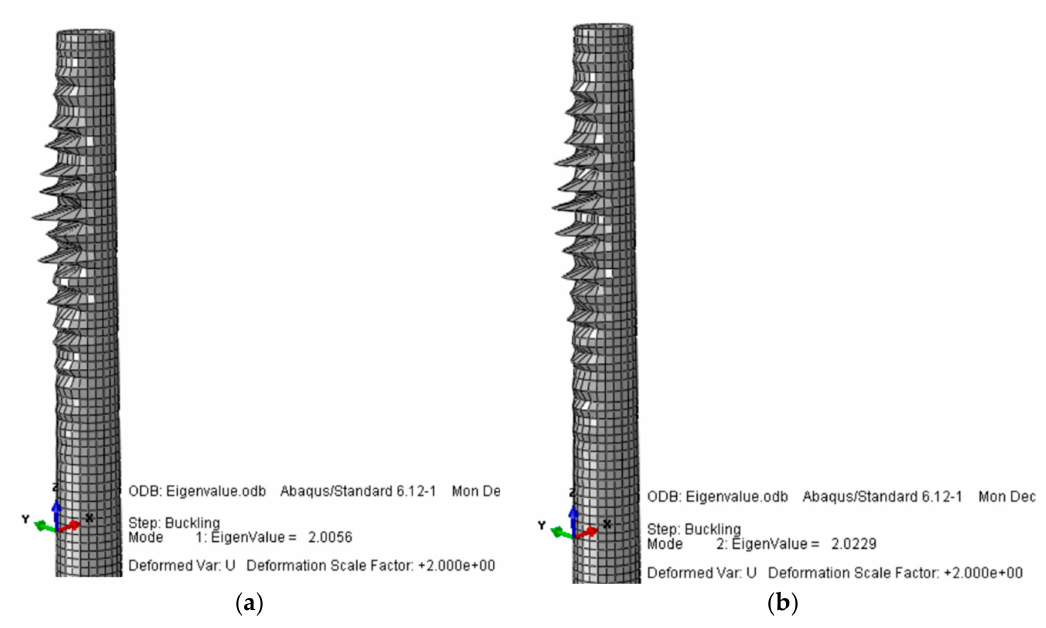
Figure 4. Eigenmodes: ( a ) 1st Eigenmode; ( b ) 2nd